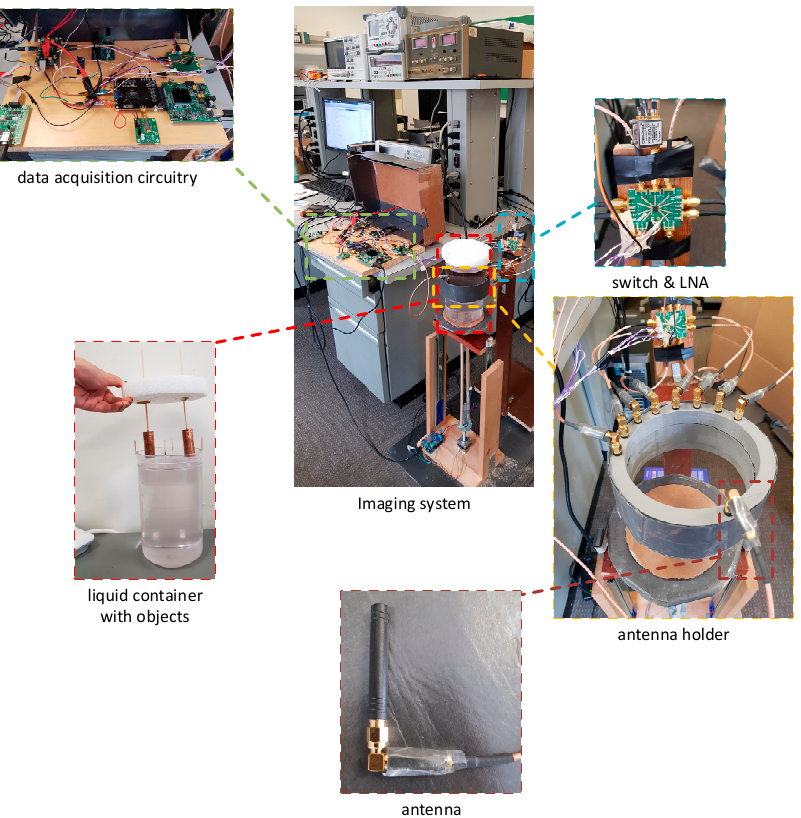
Figure 15. Imaging system with its main components.